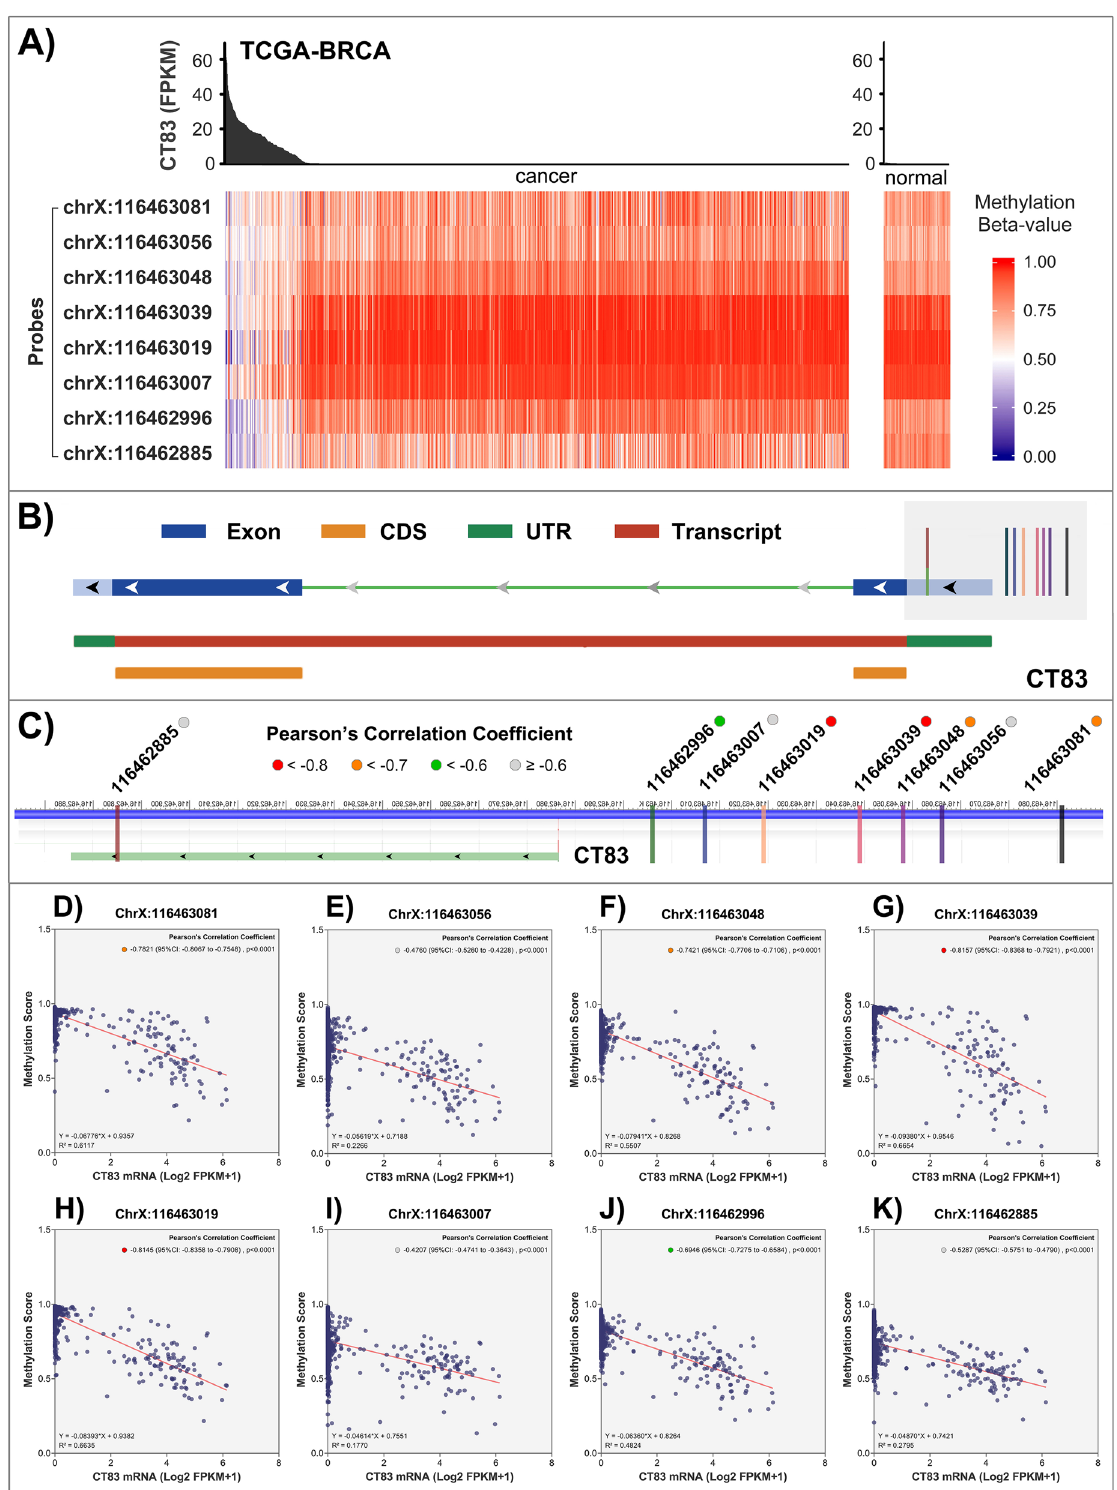
Figure 6. CT83 methylation in breast cancer. ( A ) The correlation between CT83 mRNA expression and its methylation status in breast cancer tissues. ( B ) Locations of CT83 methylation probes relative to CT83 DNA sequence. It should be noted that CT83 is located on the reverse strand of chromosome X. ( C ) Enlarged views for locations CT83 methylation probes. Pearson’s correlation coefficients between CT83 mRNA expression levels and methylation beta values were labeled as colorful dots. D-K) Pearson’s correlation coefficients between CT83 mRNA expression levels and methylation beta values of corresponding